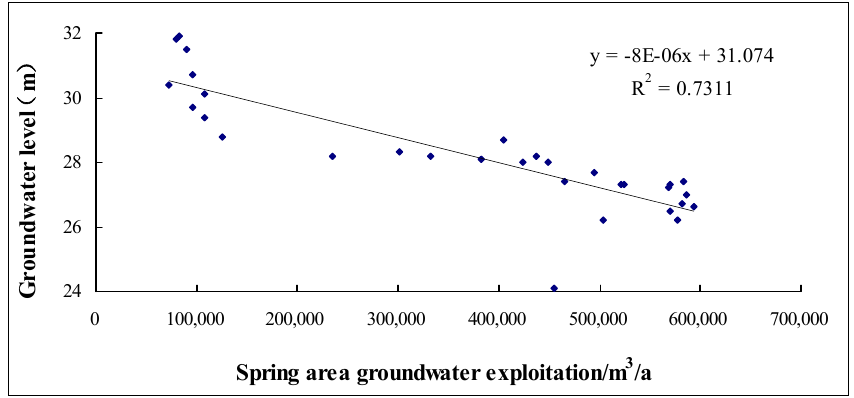
Figure 10. Relationship between spring water level and exploitation volume, 1959–1989. y = -7E-06x + 29.732